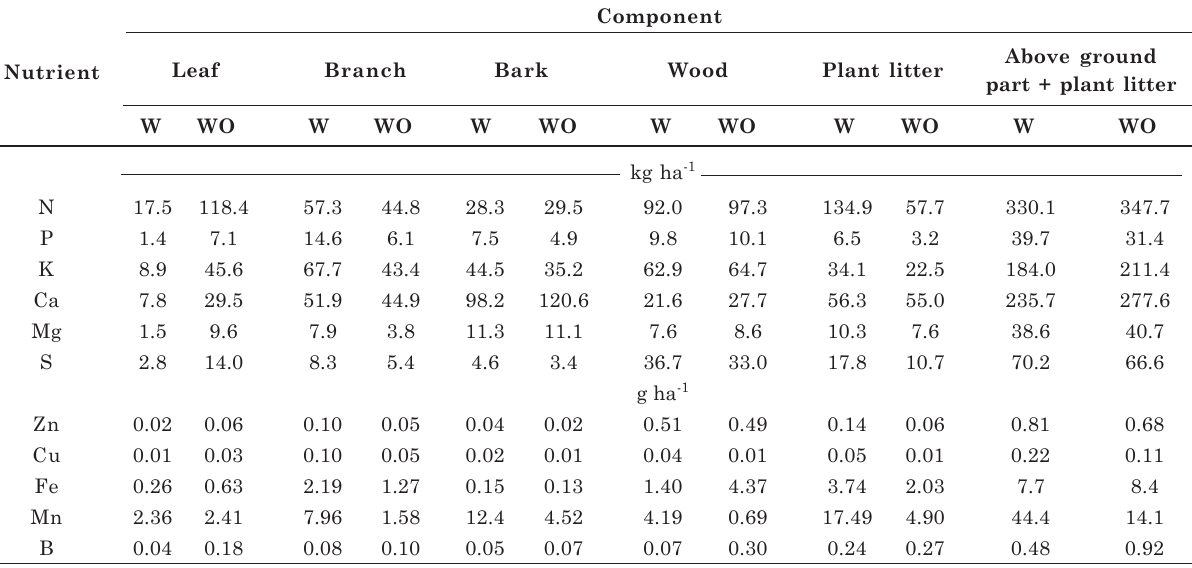
Table 8. Nutrient content in tissues of the above ground part of eucalyptus plants (clone 386) and in the plant litter in areas with (W) and without (WO) symptoms of ESBVRD Component Above ground Leaf Branch Bark Wood Plant litter Nutrient part + plant litter W WO W WO W WO